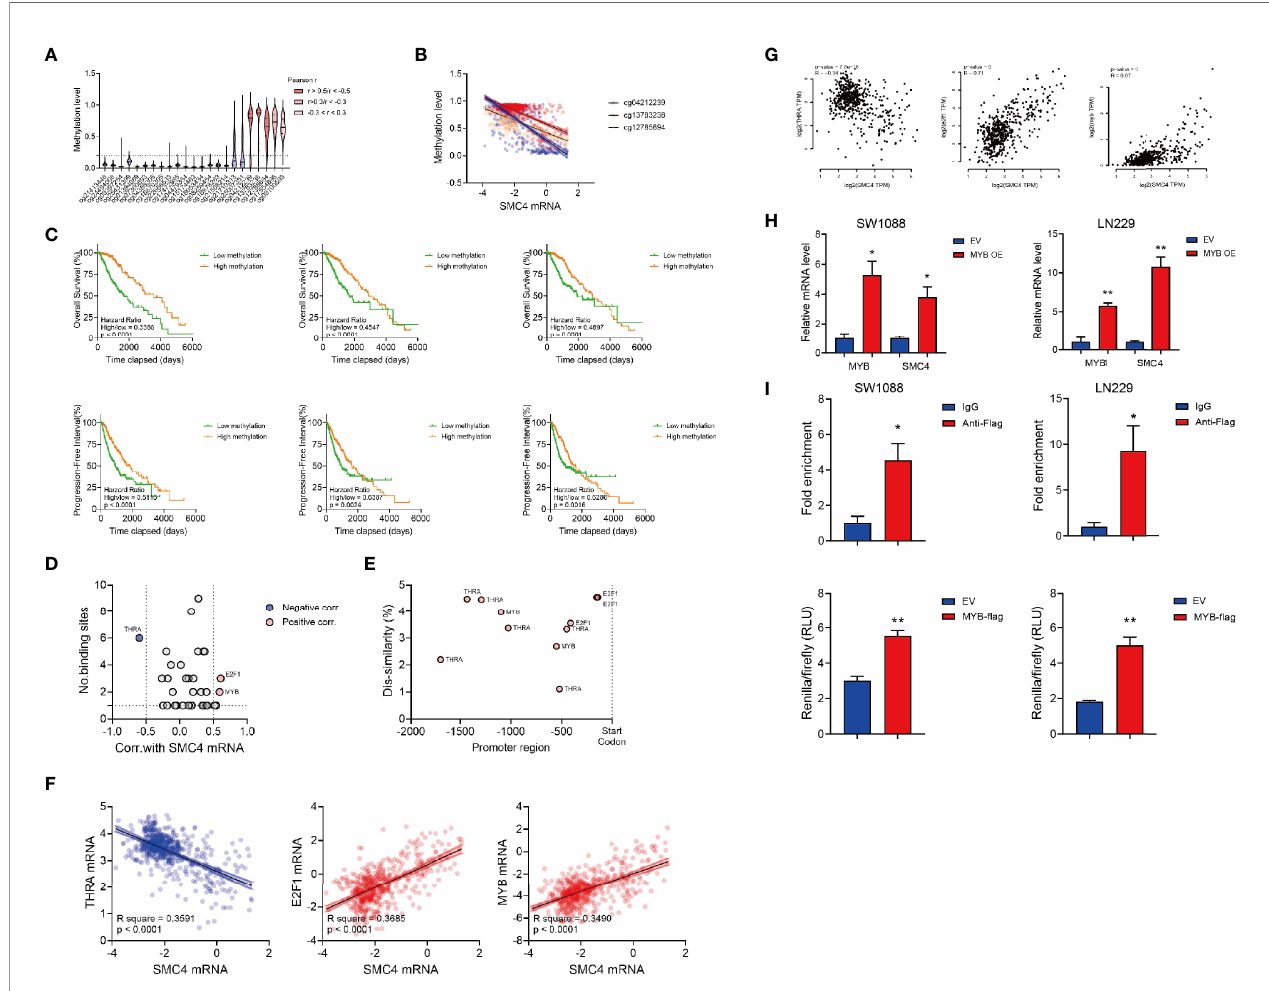
FIGURE 6 | The transcriptional modulation of SMC4. (A) Violin plot showing the relative methylation status of SMC4 DNA in glioma patients. (B) Dot plot showing the signi fi cant correlation between the methylation status and mRNA level of SMC4. cg12785694, cg13783238 and cg04212239 are shown in orange, red or blue. (C) Kaplan-Meier analysis comparing the OS and PFI in patients with different SMC4 methylation statuses. Methylation level of cg04212239 (the left panel), cg13783238 (the middle panel) or cg12785694 (the right panel) are analyzed. (D) Dot plot showing predicted binding sites on SMC4 promoter region from PROMO database and the correlation between predicted targets and SMC4 level in glioma patients in TCGA database. Pearson correlation -0.5< r <0.5 are labeled in grey; negative correlations (r < -0.5) are labeled in blue and positive correlations (r > 0.5) are labeled in red. (E) Dot plot showing the binding site of different targets on SMC4 promoter and its dis-similarity. (F, G) Dot plot showing the correlation between SMC4 level and the expression of THRA, E2F1 and MYB in TCGA database (F) or GEPIA database (G) . (H) Quanti fi cation of SMC4 and MYB mRNA level in MYB overexpressed SW1088 and LN229 cells with qPCR. GAPDH is used as an internal control for the analysis. Results from 3 different experiments. (I) The top panel: quanti fi cation of fold enrichment at the promoter region of SMC4 with ChIP- qPCR. The bottom panel: quanti fi cation of SMC4 transcription (-800bp~-1000bp) activity with dual-luciferase assay in SW1088 and LN229 cells. Results from 3 different experiments. Data were represented as mean ± SEM. *p<0.05; **p<0.01. The data were analyzed using Student ’ s